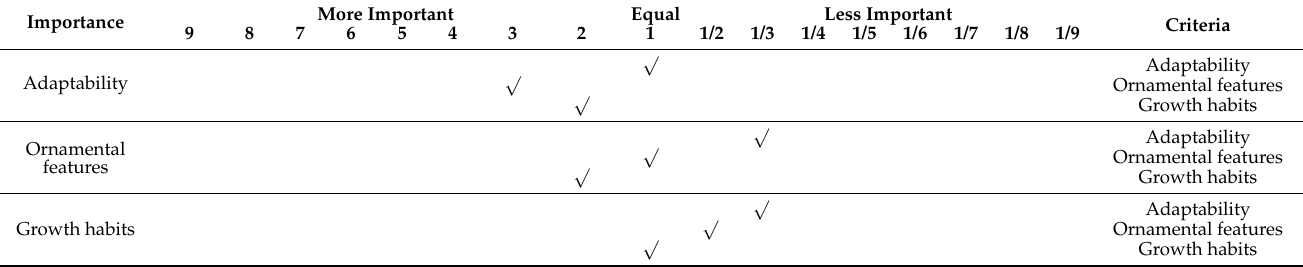
Table 6. An example of AHP questionnaire used to determine the relative importance of a